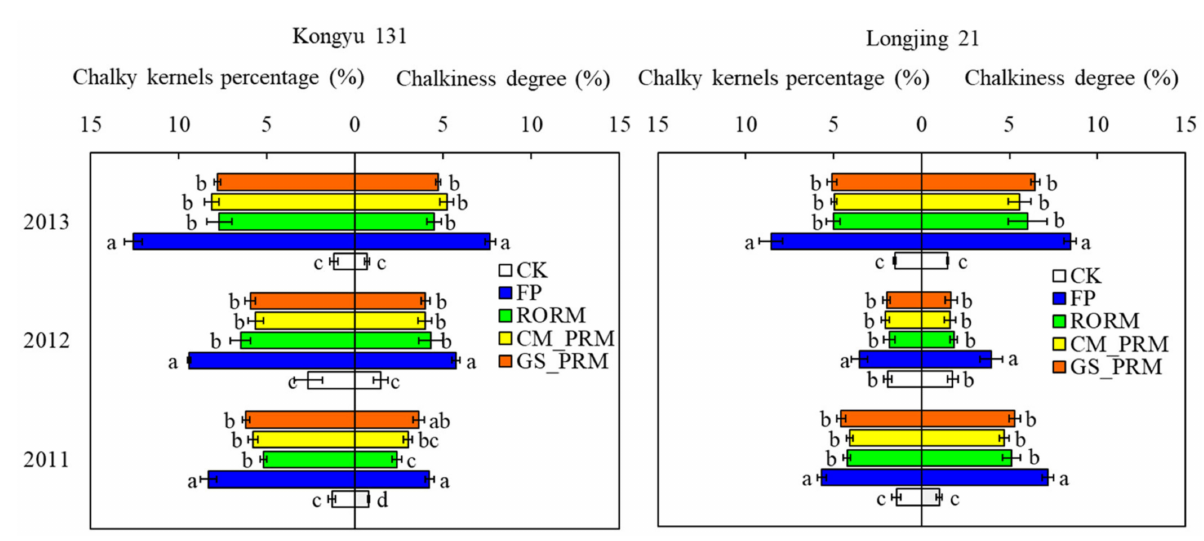
Figure 8. The appearance quality traits of different rice management systems of two rice varieties, Kongyu 131 ( left ) and Longjing 21 ( right ), from 2011–2013. CK, FP, RORM, CM_PRM, and GS_PRM represent check, farmer’s practice, regional optimum rice management, chlorophyll meter-based precision rice management, and GreenSeeker sensor-based precision rice management, respectively. Different letters indicate significant differences at p < 0.05 level in the same year. The error bars indicate standard deviations.